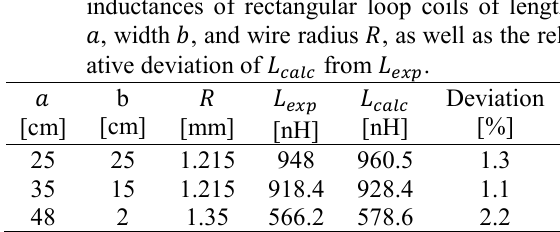
Table 1: Measured ( 𝐿 𝑒𝑥𝑝 ) and calculated ( 𝐿 𝑐𝑎𝑙𝑐 ) DC total inductances of rectangular loop coils of length 𝑎 , width 𝑏 , and wire radius 𝑅 , as well as the rel- ative deviation of 𝐿 𝑐𝑎𝑙𝑐 from 𝐿 𝑒𝑥𝑝